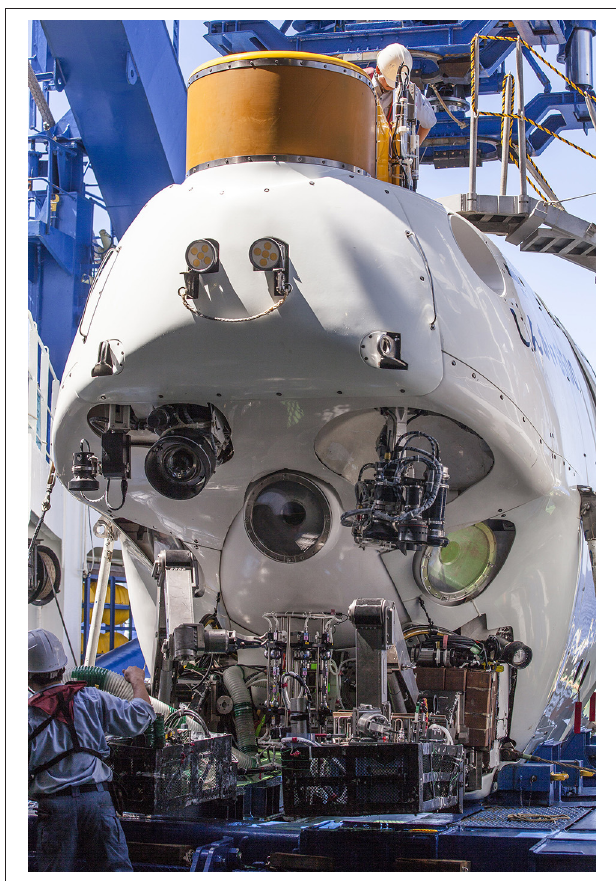
FIGURE 2 | Photograph showing the WHATS-3 being installed directly below the center window of the HOV Shinkai 6500